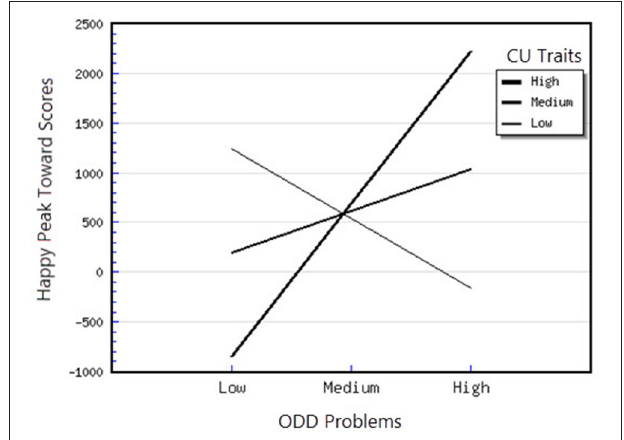
FIGURE 7 | Interaction between ODD problems and CU traits in predicting happy peak toward